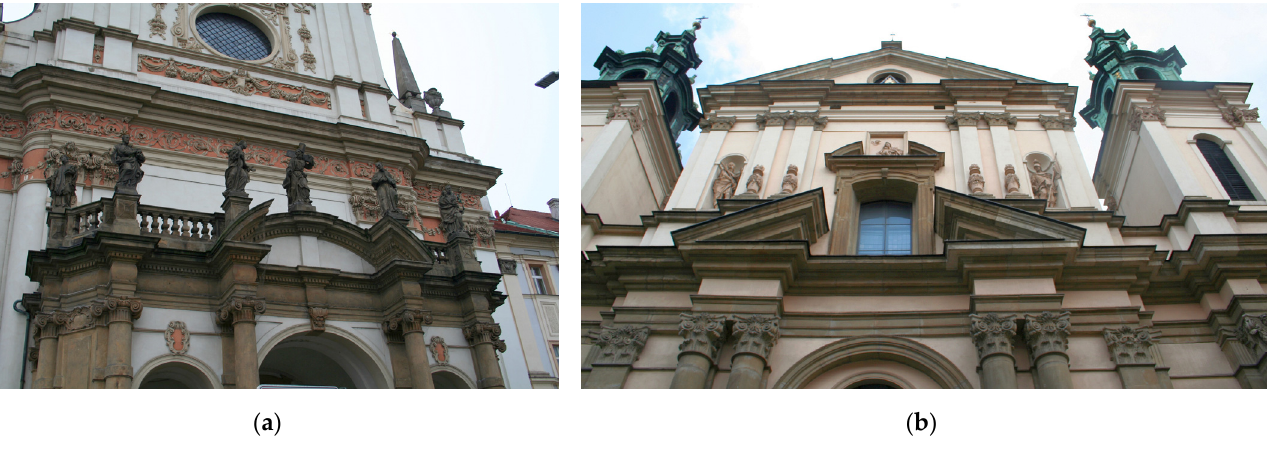
Figure 9. Entablature with a frieze of another type of stone or stucco: ( a ) colorful ornamental frieze in Carlo Lurago’s architecture. Fragment of the façade of the church of St. Ignatius in the New Town in Prague (1665–1670); ( b ) St. Anne’s Collegiate Church in Cracow, with cream-colored walls with sandstone and limestone detail. Photos by author.